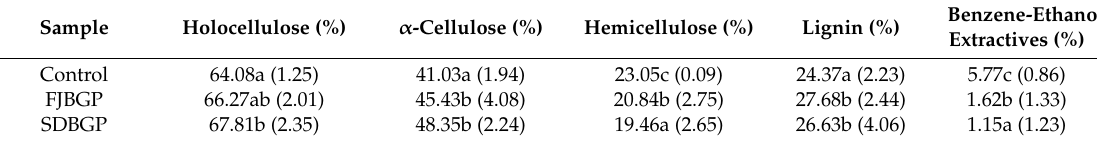
Table 1. Analysis of main chemical composition of the used BGP and control